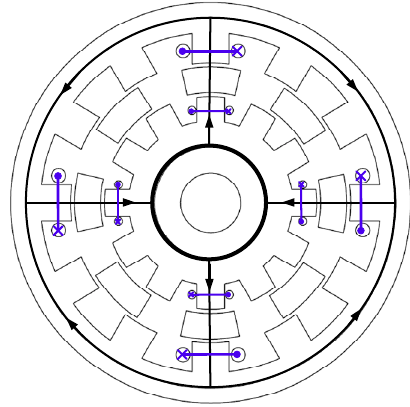
Figure 2. Magnetic flux of the single phase of DSSRM to align with the excited stator pole.